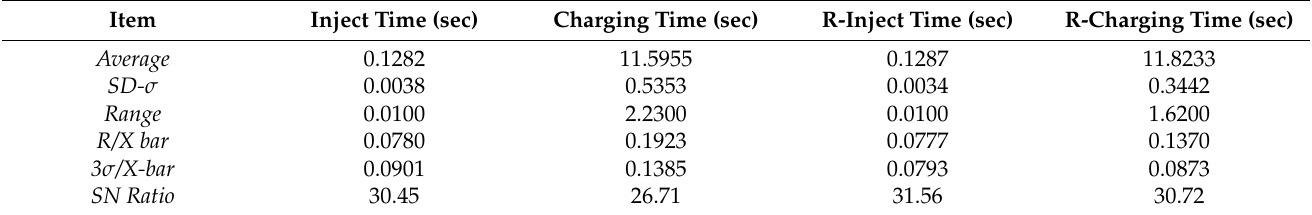
Figure 8. Relationship of screw groove L/D ratio. Table 1. Relationship of screw groove L/D